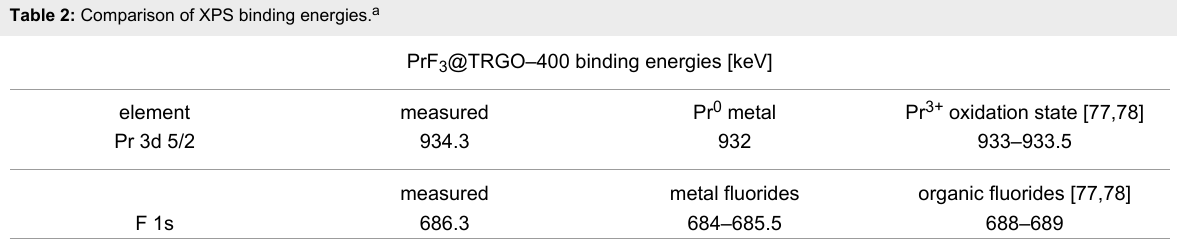
Table 2: Comparison of XPS binding energies. a